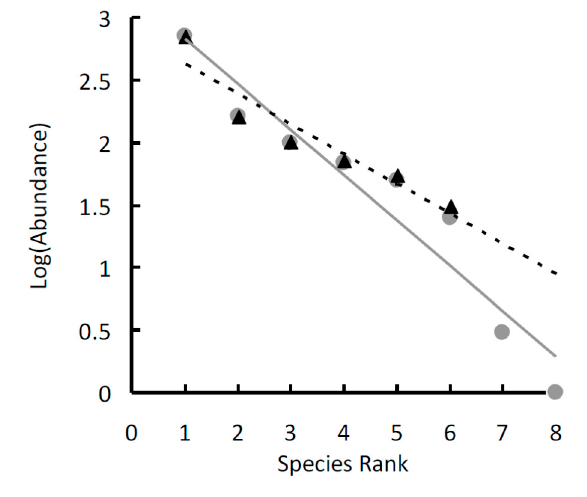
Figure 6. Rank–abundance plots of the tenebrionid beetles collected in two sites in the Ulan Buh Desert (Gobi Desert, Inner Mongolia, China): Site A (gray dots, continuous line), and Site B (black triangles, dotted line). Species are ranked from the most to the least abundant ( x -axis). Species abundances are log-transformed ( y -axis). The data were fitted using linear regressions.